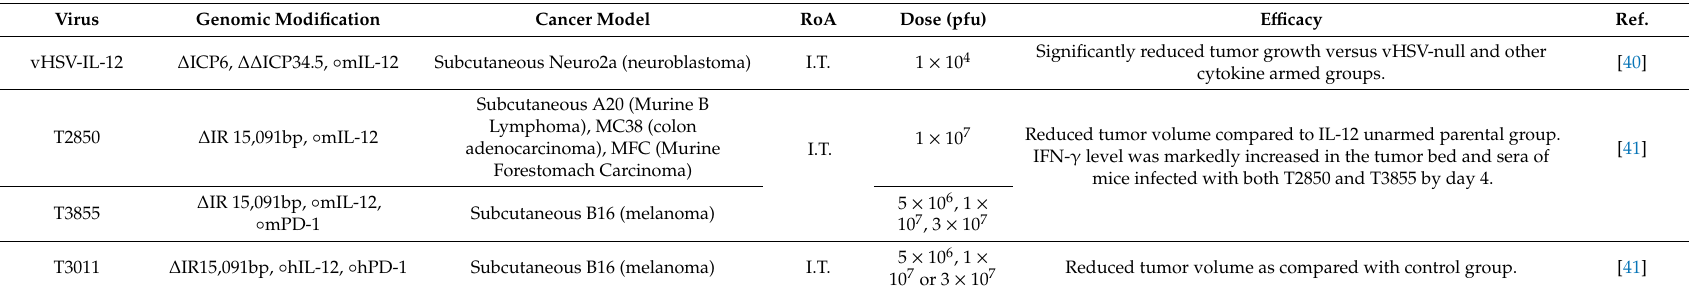
Table 2. List of IL-12 expressing oncolytic viruses (other than OHSVs) and their efficacy in pre-clinical cancer